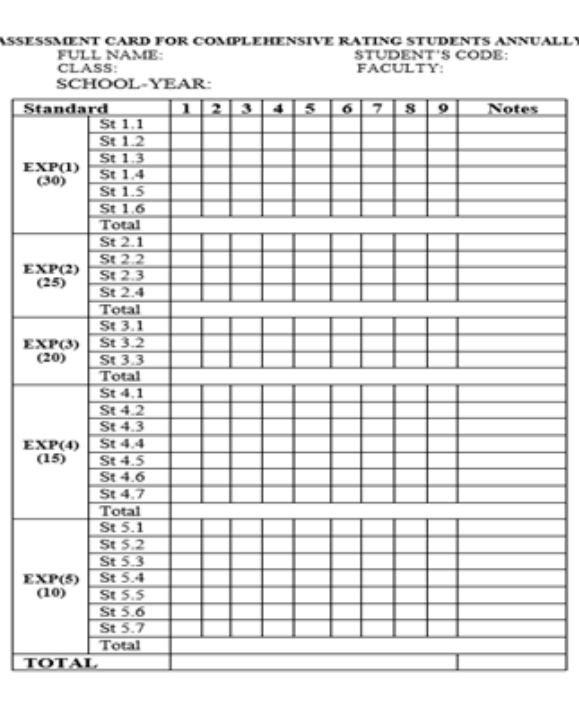
Table 1. Expert’s assessment card for rating